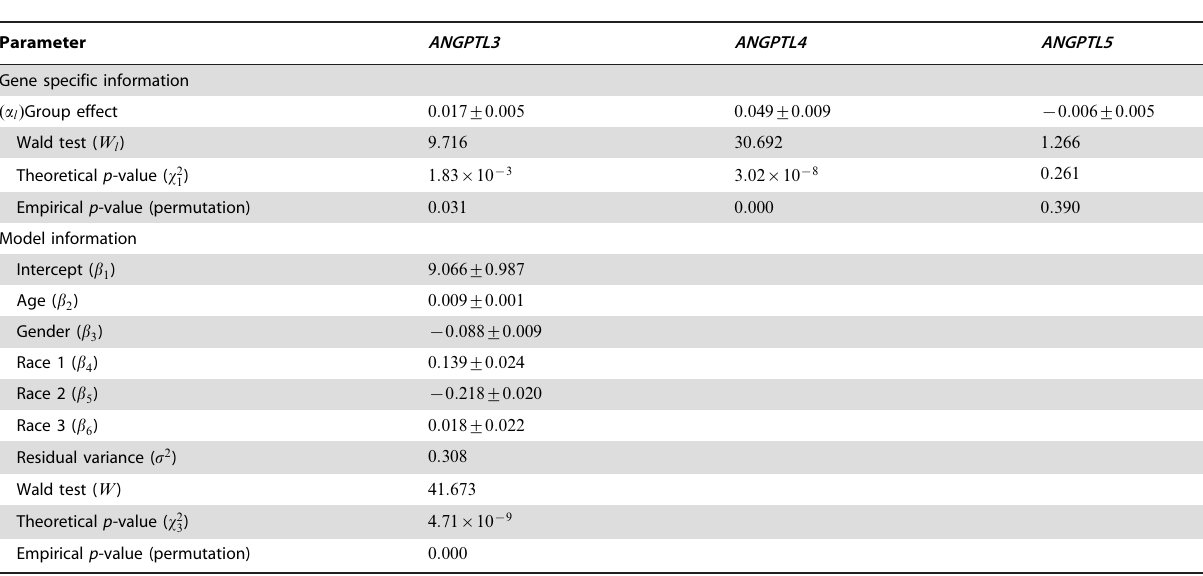
Table 4. Parameters of three genes of the Dallas Heart Study estimated jointly using the BhGLM method.